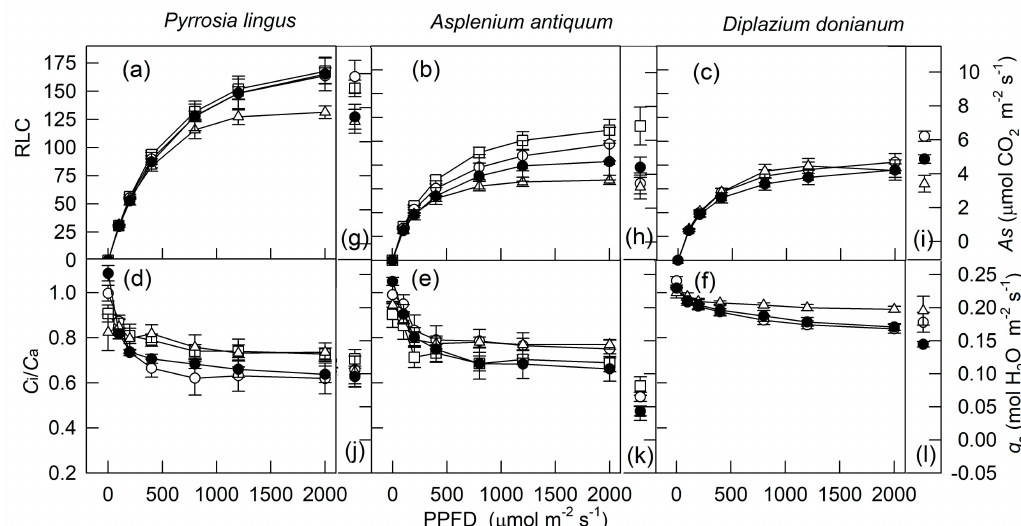
Figure 2. Light-response curves for ETR R and C i / C a ( a – f ) as well as A S and g s measured at 2000 µ mol m − 2 s − 1 photosynthetic photon flux (PPFD; g – l ) for three fern species at 25 ◦ C and 75% (open symbols, data from [3]) and 50% (closed symbols) relative humidity. A S and g s indicate the net photosynthetic rate and stomatal conductance, respectively, from steady-state light response; ETR R indicates electron transport rate from rapid light response; C i and C a indicate intercellular and atmospheric CO 2 concentration, respectively. Squares, circles, and triangles indicate cultivated under 100%, 50%, and 10% sunlight, respectively. Data are mean ± SE.